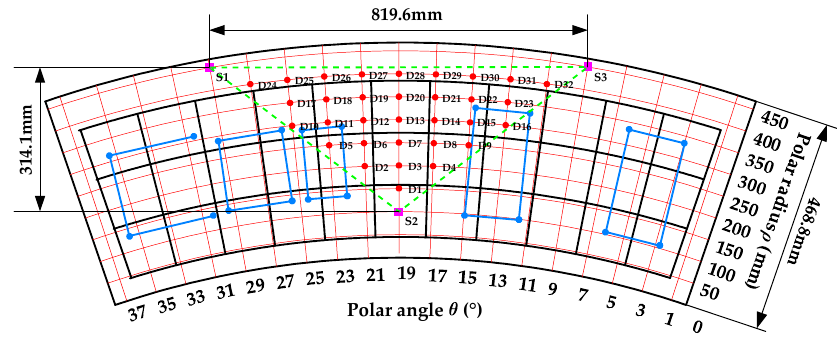
Figure 12. The distribution of impact points.